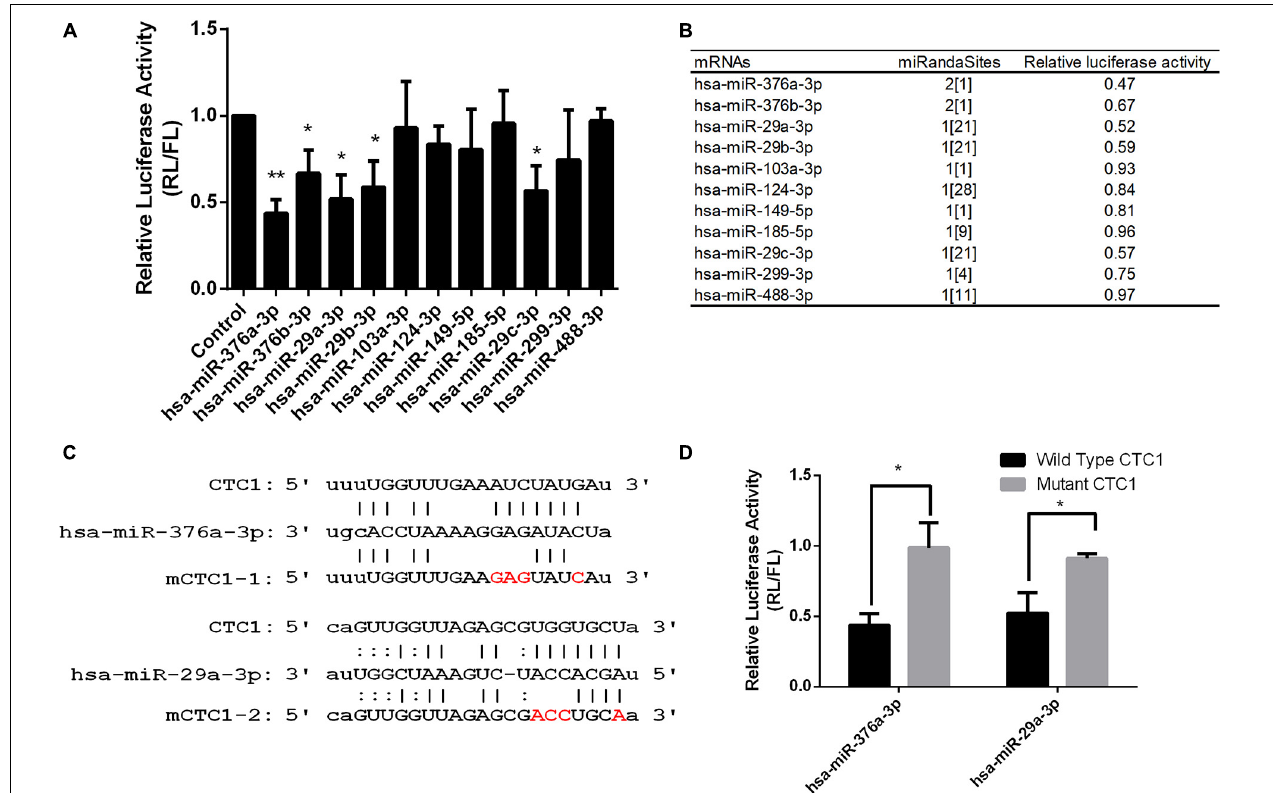
FIGURE 1 | Several microRNAs (miRNAs) were identified to target CTC1. (A) Dual-luciferase assay report of HEK293T cells that expressed the indicated miRNA targeting the CTC1 3 (cid:48) -UTR. (B) List of candidate miRNAs tested by the luciferase assay and the number of miRanda screening read sites. (C) Predicated binding sites of miR-376a and miR-29a on the CTC1 3 (cid:48) -UTR. Mutant sites in the seed region were labeled in red . (D) Luciferase activity of cells expressing the wild-type CTC1 or mutant CTC1 3 (cid:48) -UTR with the selected miRNAs. P values were determined by Student’s t test. An asterisk was annotated on the panel if the statistical P < 0.05 compared to the